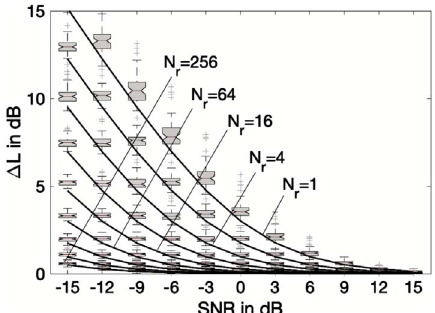
Figure 10. Error according to Equation (11) in the prediction as function of receiving positions and signal to noise ratio shown as boxplots. The results are compared with the error predicted by Equation (12) (solid lines). The upper curve corresponds to 1 receiving position. The consequent curves correspond to 2, 4, 8, 16, 32, 64, 128 and 256 (lowest curve) receiving